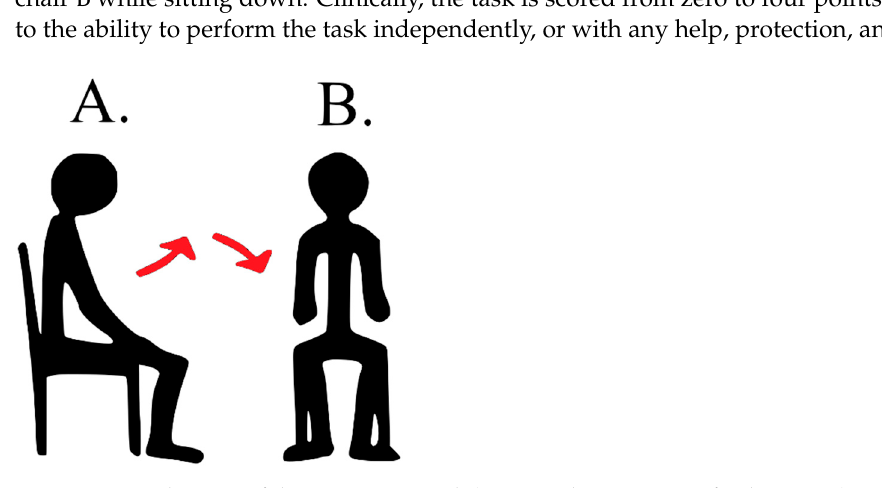
Figure 6. Visualization of the Swap Seats task (A – initial position, B – final